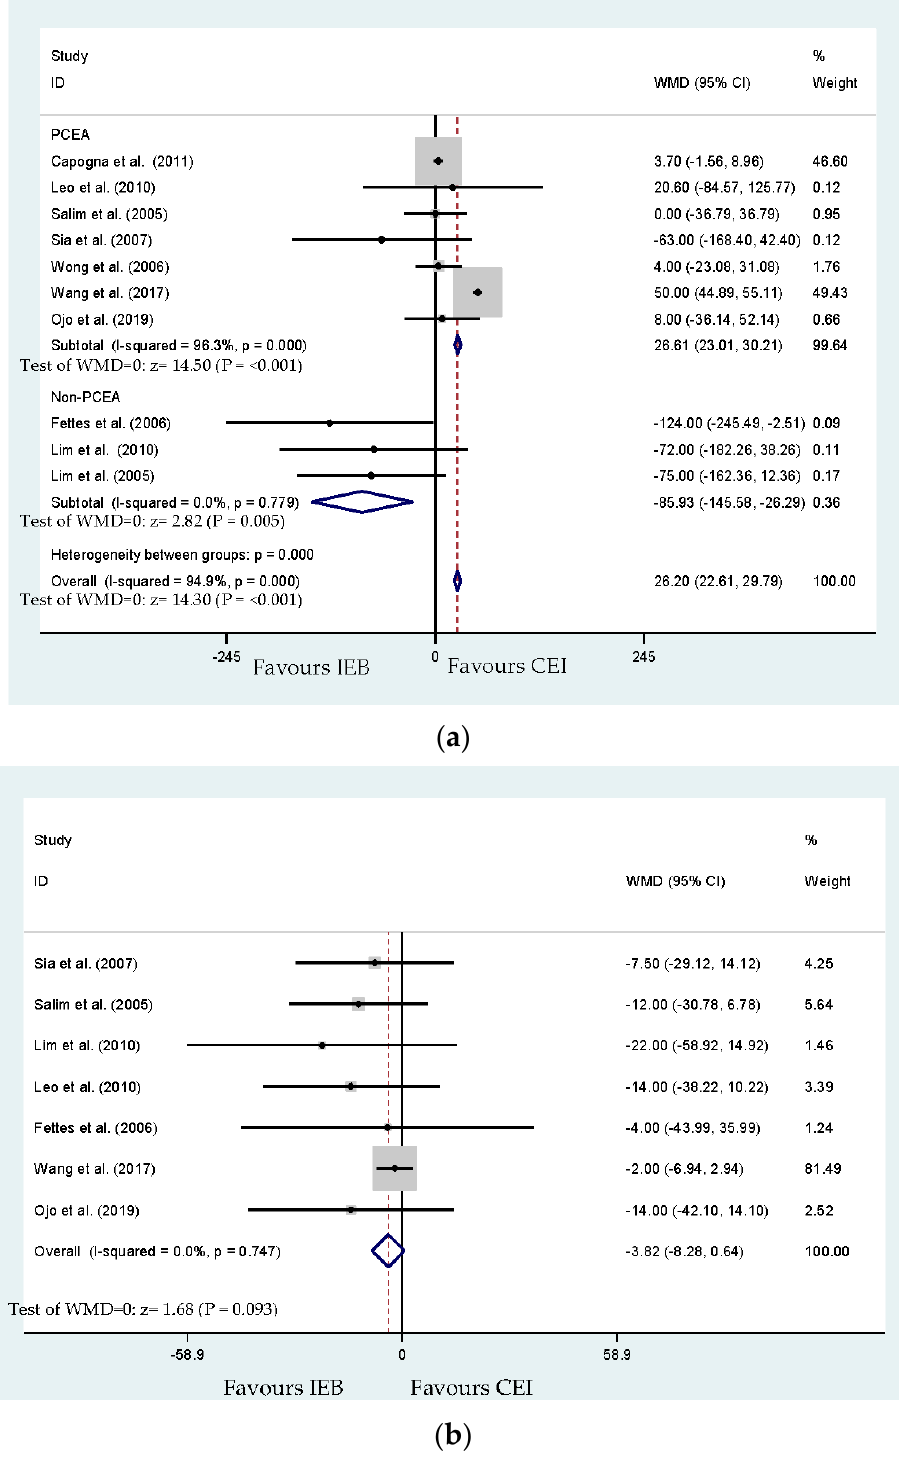
Figure 4. ( a ) . Effect of overall and subgroup analysis of the total duration (minutes) of labor analgesia. PCEA: Patient-controlled epidural analgesia. ( b ) Overall effect for the duration (minutes) of the second stage of labor analgesia.